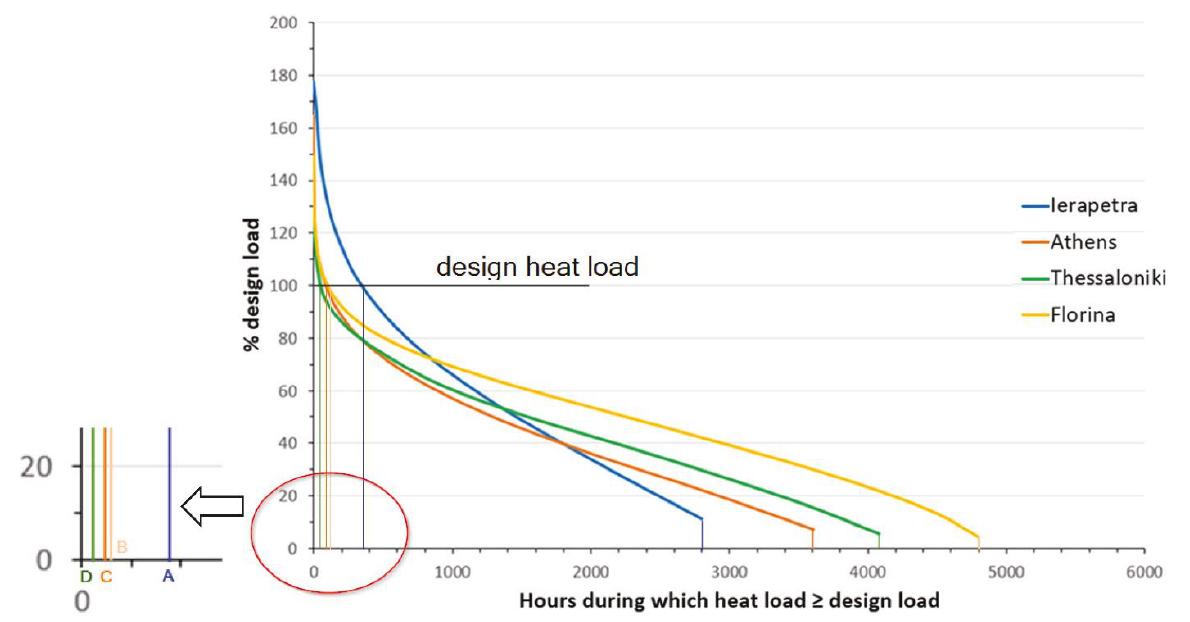
Figure 1. Heating period duration (h) for each city and number of hours during which the heat load ≥ design heat load